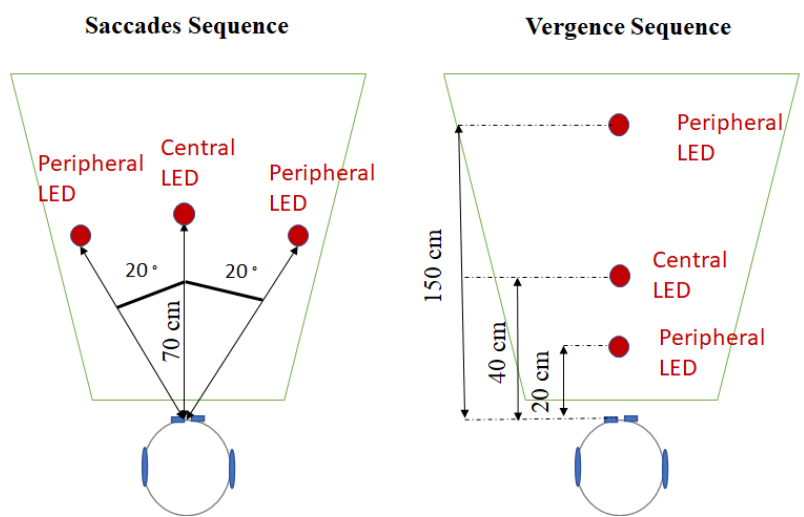
Figure 1. Top-view of the position of the LEDs for the saccades sequence (on the left) and for the vergence sequence (on the